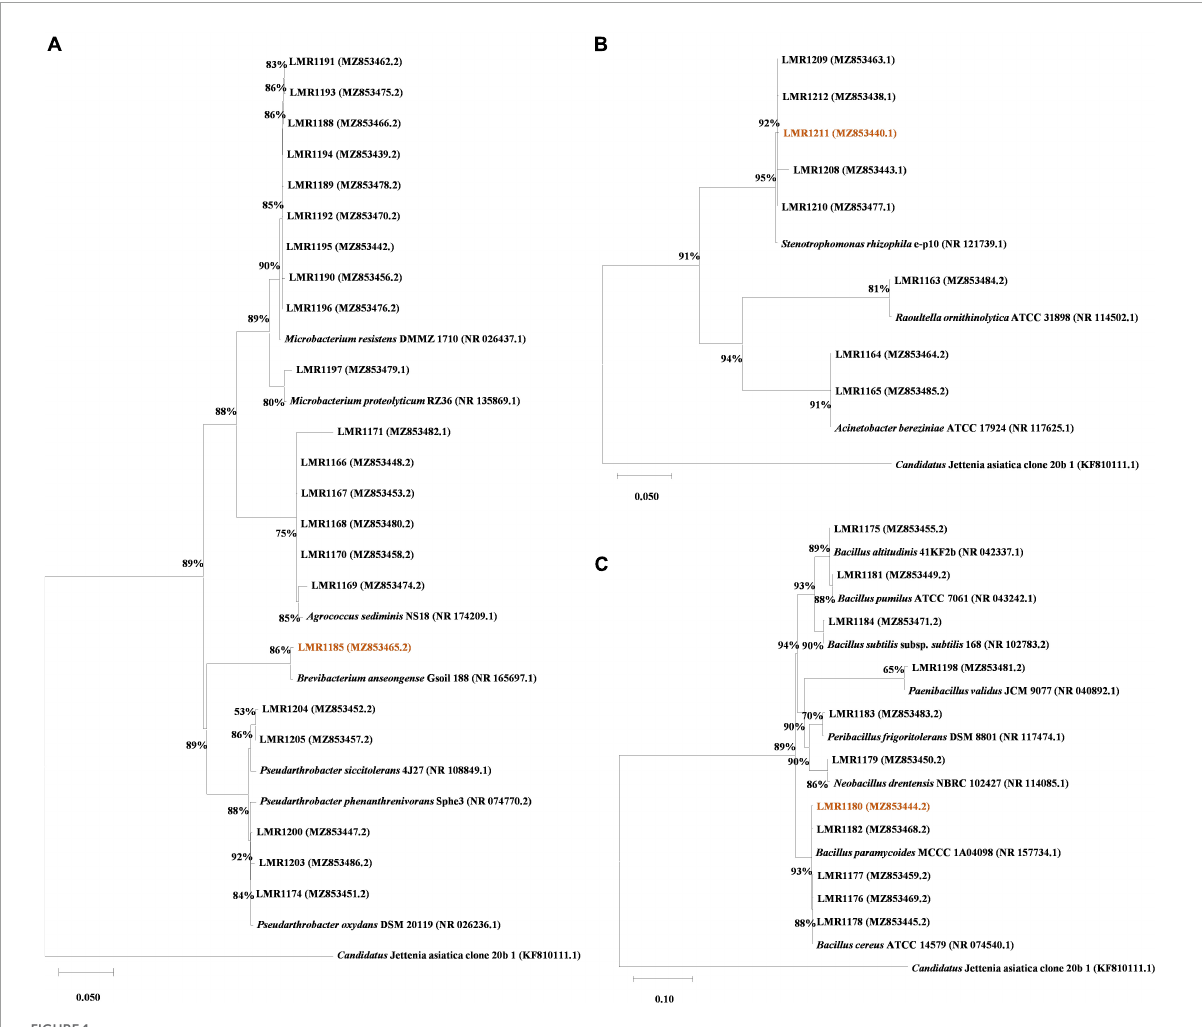
FIGURE1 Phylogenetic trees of all isolated strains (indicated in bold) based on ClustalW aligned 16S rRNA gene. A total of 1,617 nt were used for Actinobacteria phylum alignment (A) , 1,526 nt were used for the Proteobacteria phylum alignment (B) , and 1,622 nt were used for the Firmicutes phylum alignment (C) . The Tamura-Nei model (Tamura and Nei, 1993) with a discrete Gamma distribution was used to construct the phylogenetic trees. Accession numbers are given between parenthesis. The bootstrapping replicates was 1,000 for all trees and the percentage of replicate trees is shown beside the branches. Candidatus Jettenia asiatica clone 20b_1 was used as outgroup, and the strains used for in planta test are